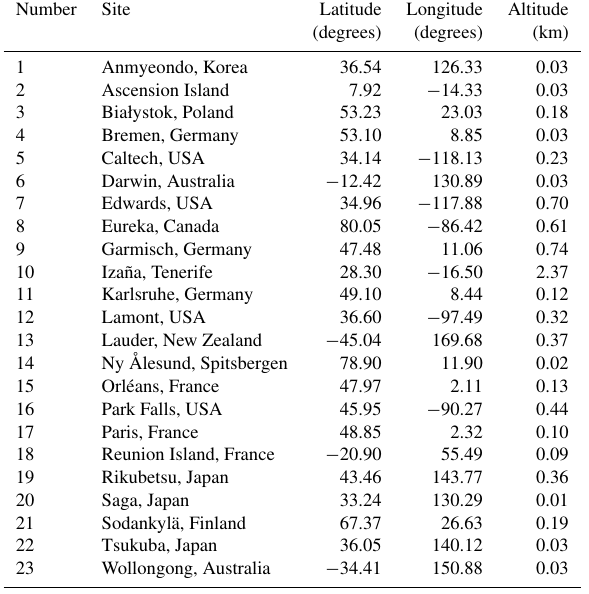
Table 1. Details of operational TCCON sites. Number Site